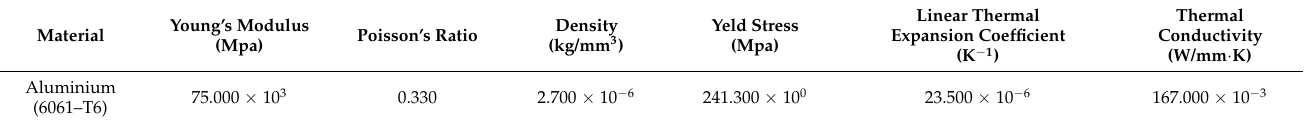
Table 2. The material characteristics.